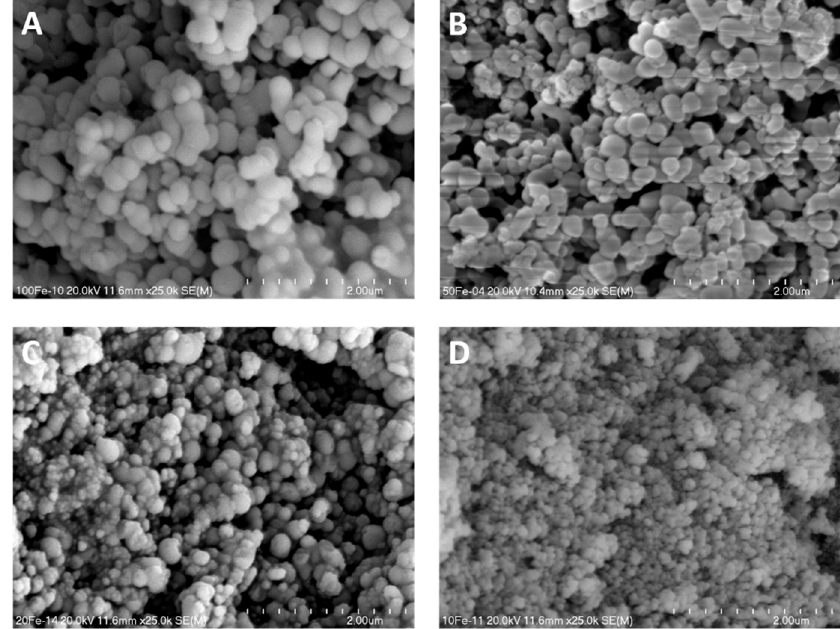
Figure 5. SEM images of spherical MCM-41 modified with iron: 100Fe-MCM-41 ( A ), 50Fe-MCM-41 ( B ), 20Fe-CM-41 ( C ), and 10Fe-MCM-41 ( D ).